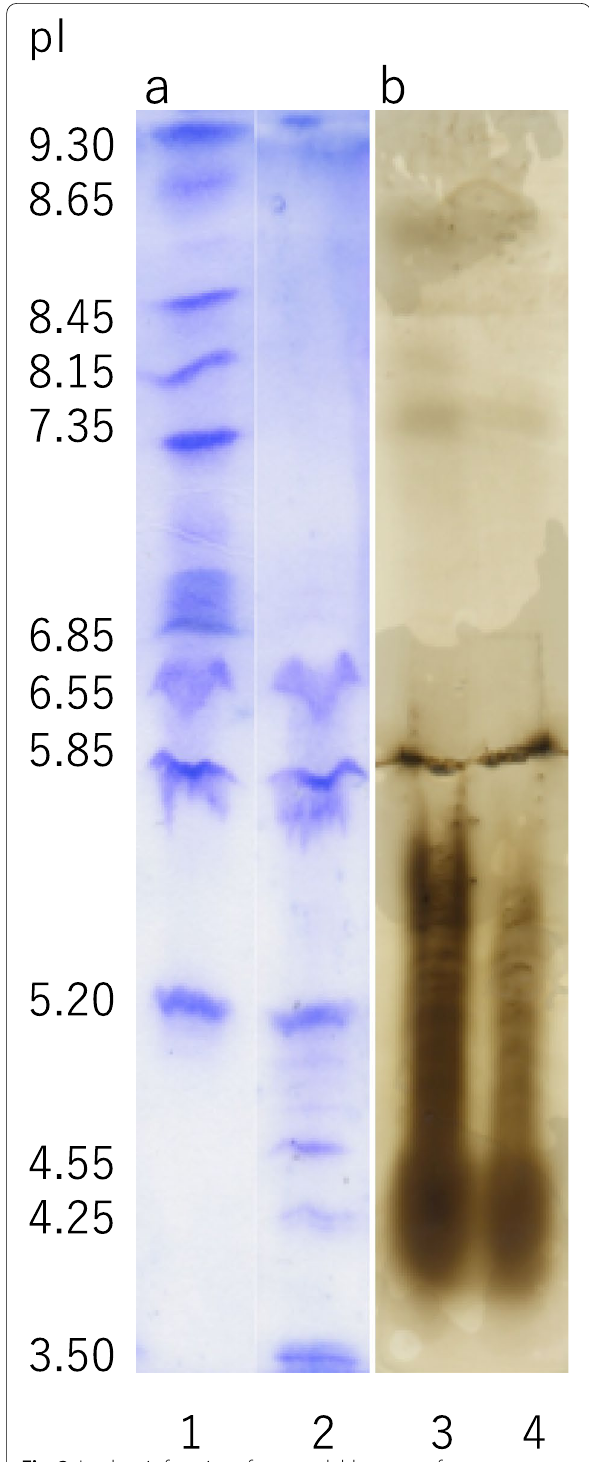
Fig. 2 Isoelectric focusing of water-soluble extracts from acetone powder prepared from the lacquer: a stained with Coomassie Blue R 250; b stained with gallic acid. 1, high pI marker; 2, low pI marker; 3, Sample No. 4 in Table 1; 4, No.